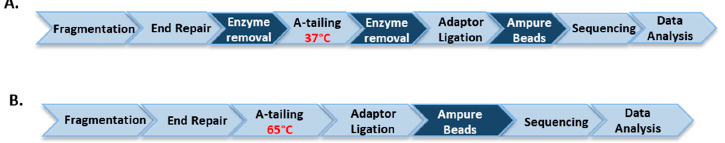
Figure 6. Workflows for Illumina library construction using immobilized or soluble DNA modifying enzymes. ( A ) End repair reactions including DNA blunting and phosphorylation are carried out by immobilized T4 DNA polymerase and T4 polynucleotide kinase, respectively, which are covalently conjugated to magnetic beads and are removed prior to 3 (cid:48) A-tailing using immobilized Taq DNA polymerase at 37 ◦ C. ( B ) DNA end repair and 3 (cid:48) A-tailing are catalyzed by a mixture of the soluble enzymes described above. Following the end repair step 3 (cid:48) A-tailing is performed at 65 ◦ C. The use of immobilized enzymes circumvents the requirement of high temperature treatment of DNA